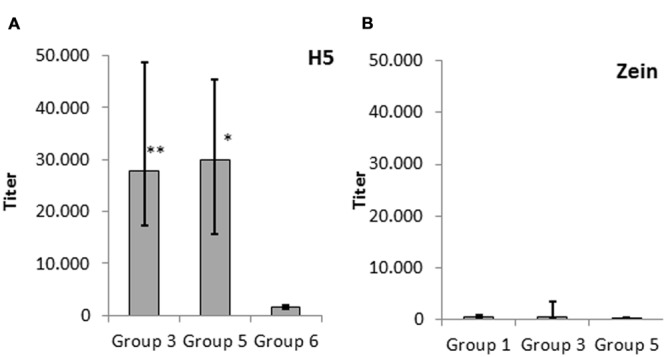
Serum IgG response against (A) H5 and (B) zein. Data represent the median endpoint titer per group, whereas the lower and upper ends of the error bars represent the first and third quartiles, respectively. (A) Statistical analysis to compare group 3 (H5-zein without adjuvant) and group 5 (H5 with adjuvant) vs. group 6 (H5 without adjuvant). (B) Statistical analysis to compare group 1 (H5-zein with adjuvant) and group 3 (H5-zein without adjuvant) vs. group 5 (H5 with adjuvant). Each treatment group comprised 10 mice. Statistical significance was determined by Student’s t-test (∗∗p < 0.01; ∗p < 0.1; no asterisk indicates p > 0.1).